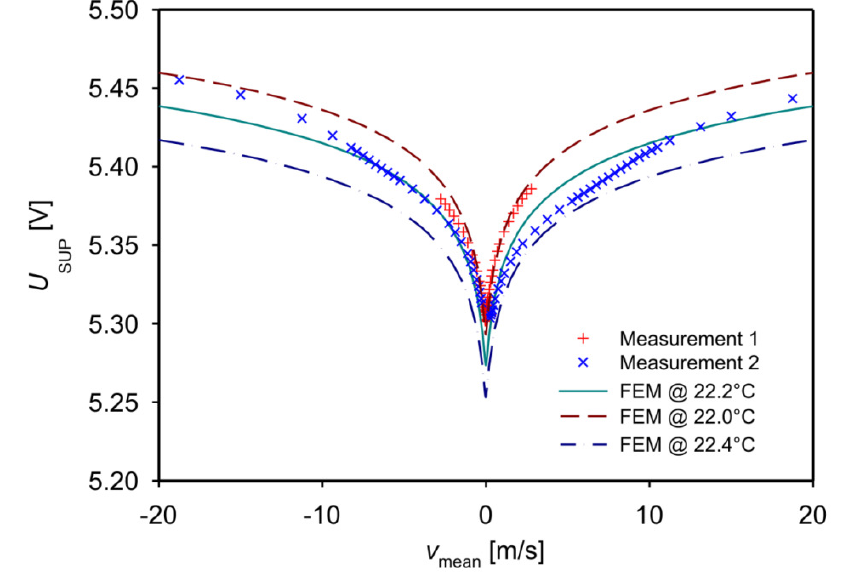
Figure 9. Measured and simulated dependence of U duct (design 1). Flow controllers of 100 cm 3 /min (+) and 2000 cm 3 /min (×) capacity were used alternately to establish the flow. The simulated characteristics assume equal values for the fluid and chip